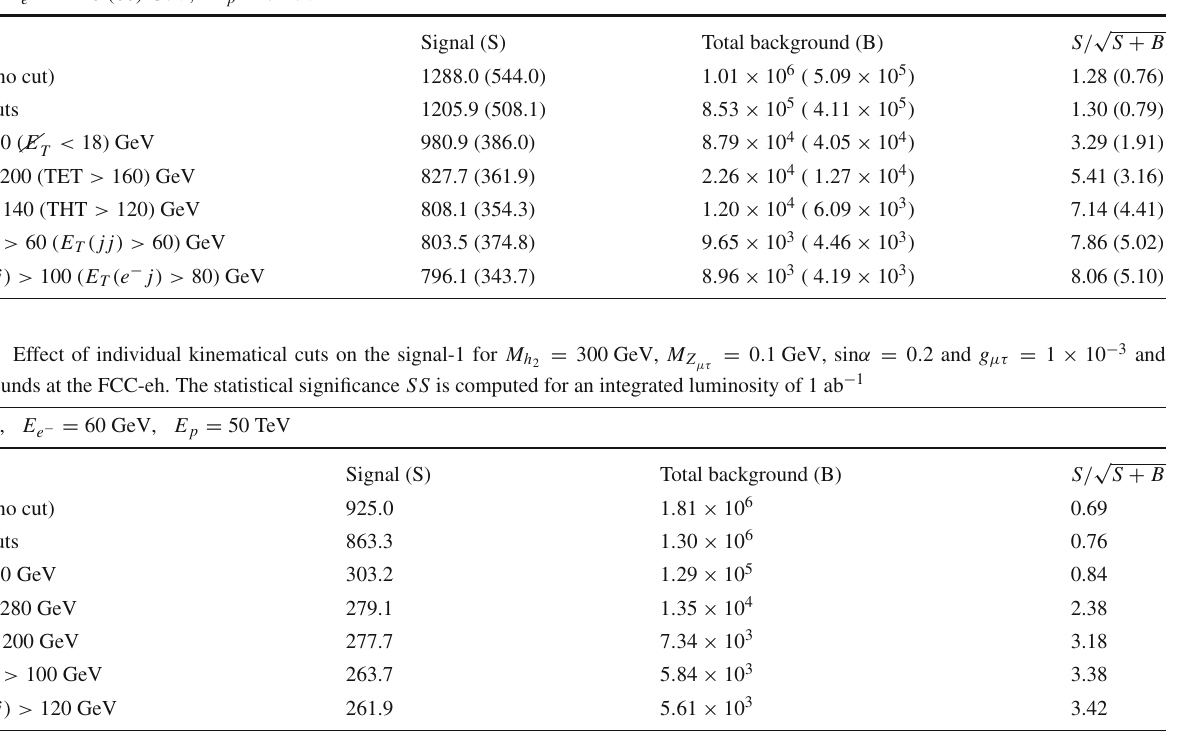
Table 3 Effect of individual kinematical cuts on the signal-2 for M Z LHeC with E e − = 140 ( 60 ) GeV. The statistical significance is computed for the integrated luminosity as 1 ab − 1 LHeC, E e − = 140 ( 60 ) GeV, E p = 7 TeV